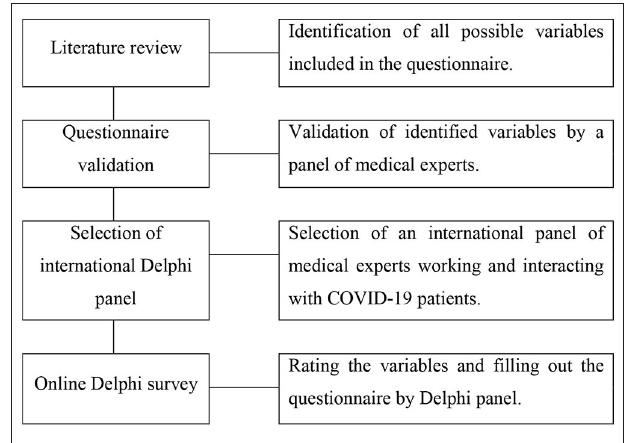
FIGURE 1 | Flowchart of Delphi